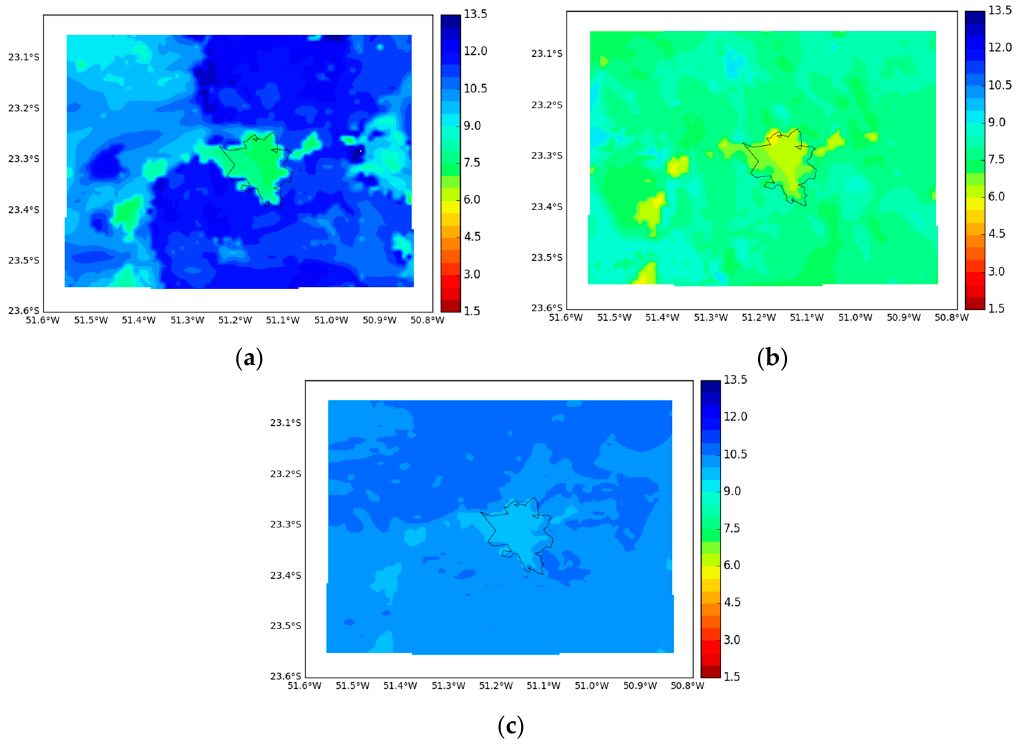
Figure 7. Specific humidity at 2 m (in g/kg) for 18 Z at 22 July 2015 for simulation with ( a ) GFS; ( b ) SRESB1 and ( c ) SRESA2 simulations.